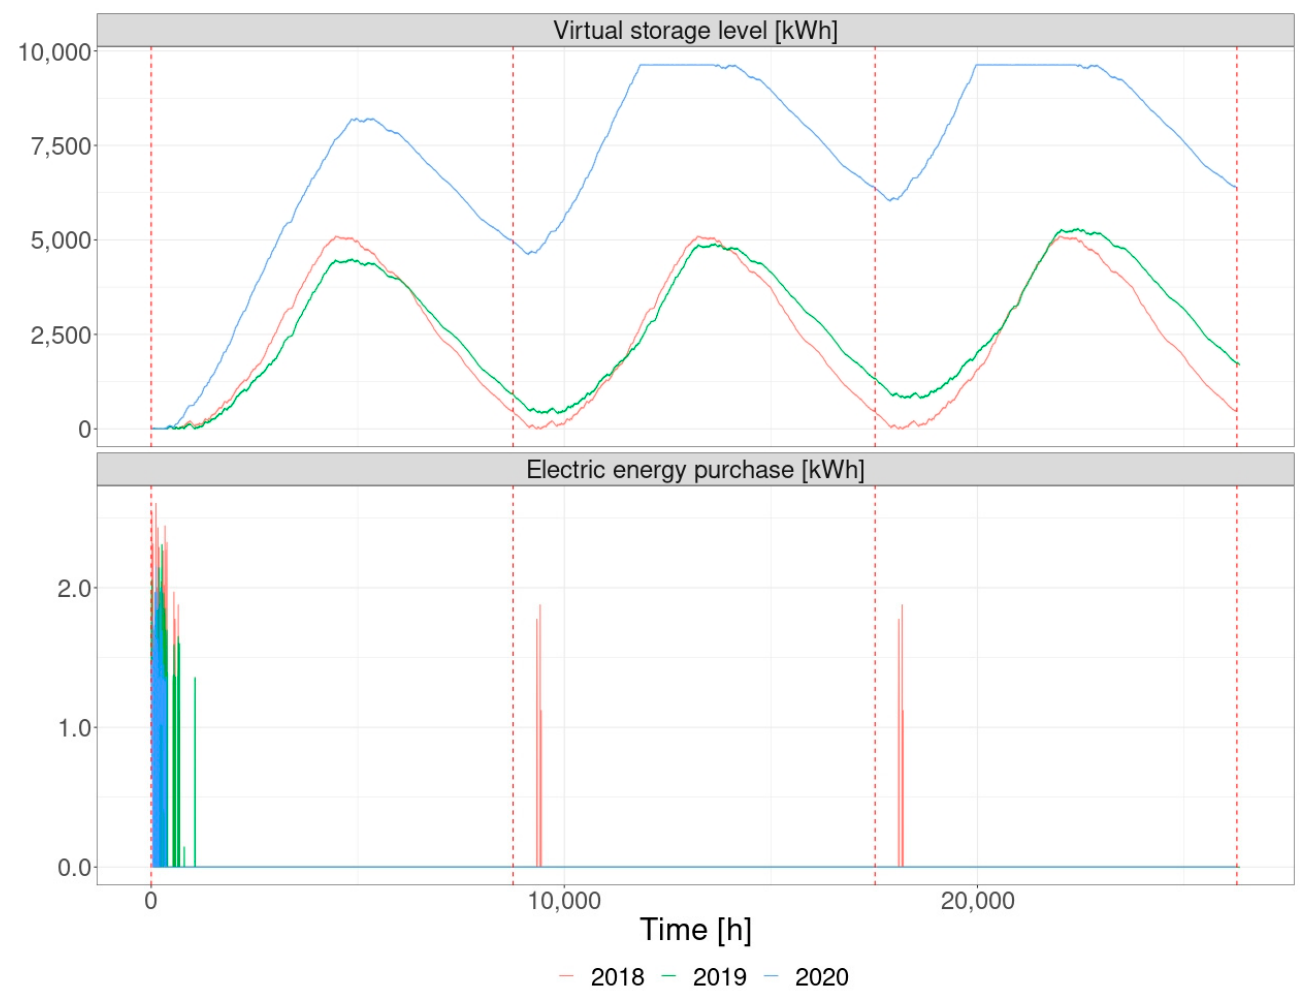
Figure 1. Visualization of the virtual storage fill level and energy purchase time series based on the Swimming Pool example, broken down by training period and test periods.